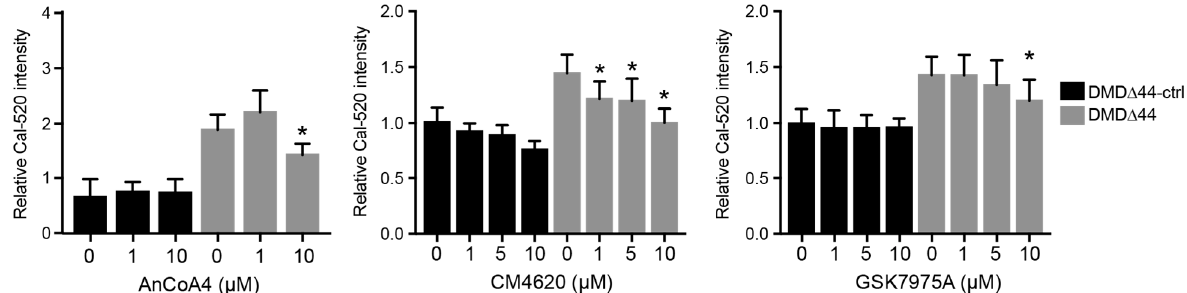
Figure 2. STIM1–Orai1 regulated Ca 2+ overload in dystrophic myotubes. The Ca 2+ peak level using Orai1/STIM1 inhibitors. * indicates p < 0.05.